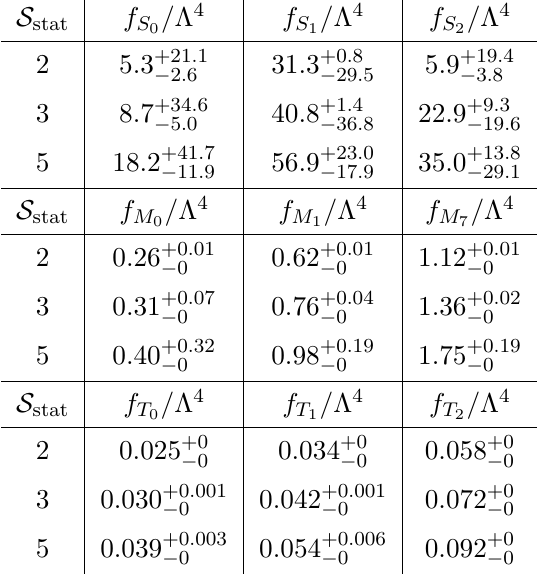
Table 8 . The expected constraints on the absolute values of coefficients ( 10 − 3 TeV − 4 ) at and L = 90 ab − 1 . The results by varying the unitarity bounds by factors 1 / 2 and 2 are presented as systematic